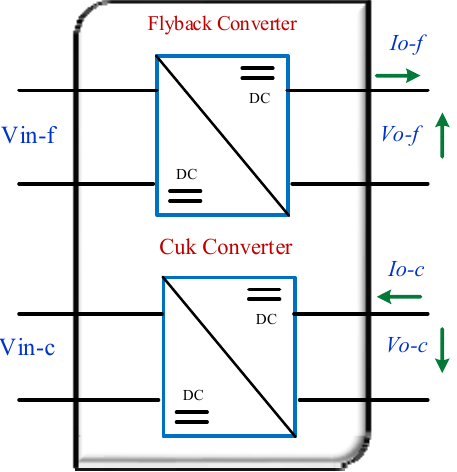
Figure 1. The conventional use of flyback and Cuk converters.